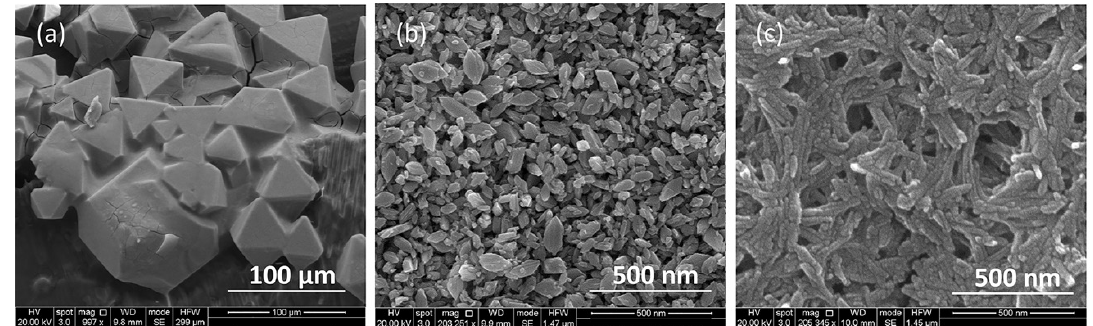
Fig. 4 (a) SEM image of compound 1 , (b) and (c) SEM images of nanoscale 1 formed by different ethanol/water volume ratio including 1:1 and 2:1.